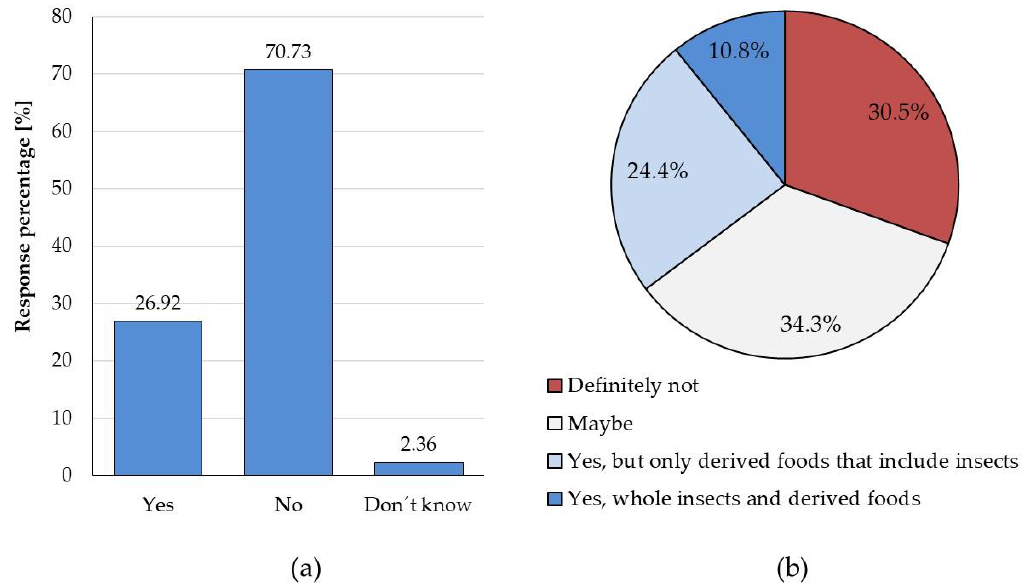
Figure 1. ( a ) Distribution of answers to the question “Have you ever eaten insects as culinary preparations, as snacks or other derived products?”. N = 510; ( b ) distribution of answers to the question “If you have never eaten insects, would you consider eating them?”